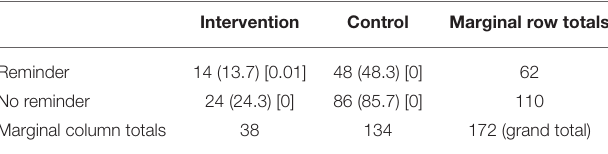
TABLE 5 | Sub-aim 1: differentiation not found between the IG and CG regarding the decision to change current caffeine consumption with the help of set goals and reminders ( p = 0.80).